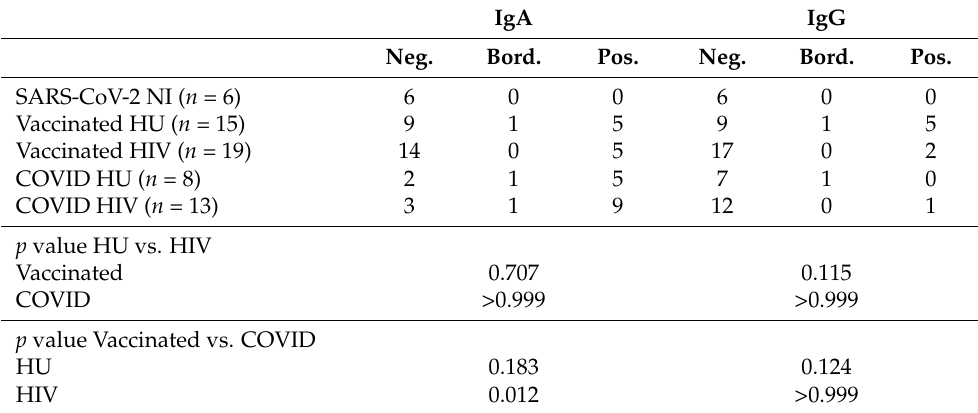
Table 7. Proportions of donors with measurable anti-spike antibodies in the